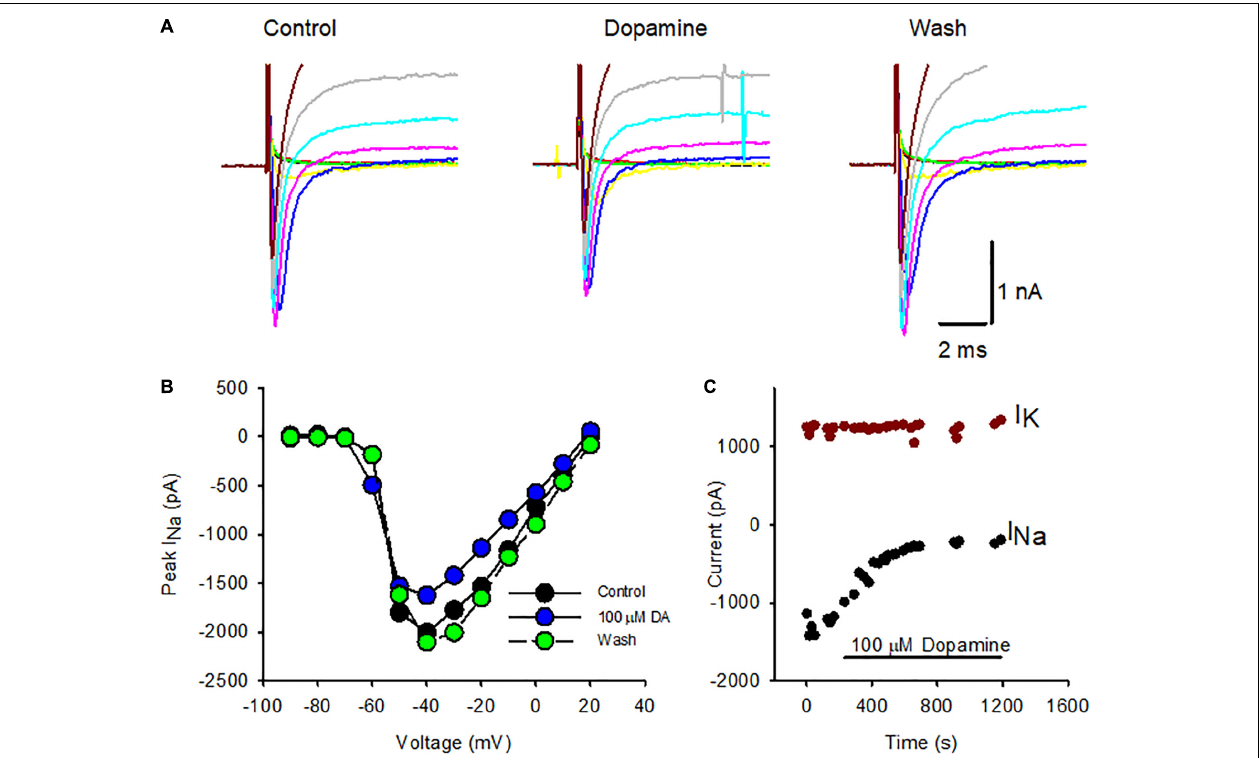
FIGURE 1 | Effect of dopamine on Na + and K + currents in isolated calyx terminals. (A) Whole cell currents in an isolated calyx in response to a series of voltage steps from –90 to –10 mV following a prepulse to –130 mV. Transient Na + currents were reduced in response to application of 100 µ M dopamine and recovered following washout. (B) Current-voltage plot comparing peak I NaT at each voltage step in control conditions (black circles), during dopamine (DA) perfusion (blue circles, 6 min of perfusion) and following washout (green circles, 10 min of perfusion). P24 calyx, female. (C) I NaT and steady state potassium current (I K ) were measured during perfusion of 100 µ M dopamine to an isolated calyx. Peak I NaT was measured at successive voltage steps to –40 mV following a prepulse to –130 mV to remove Na + channel inactivation (black circles) and showed a sustained decrease with dopamine application. I K was measured at the end of 40 ms for the voltage step to +20 mV (dark red circles) and remained constant throughout dopamine perfusion. P21 calyx, male. Electrode solution contained K + and the external solution was L-15.